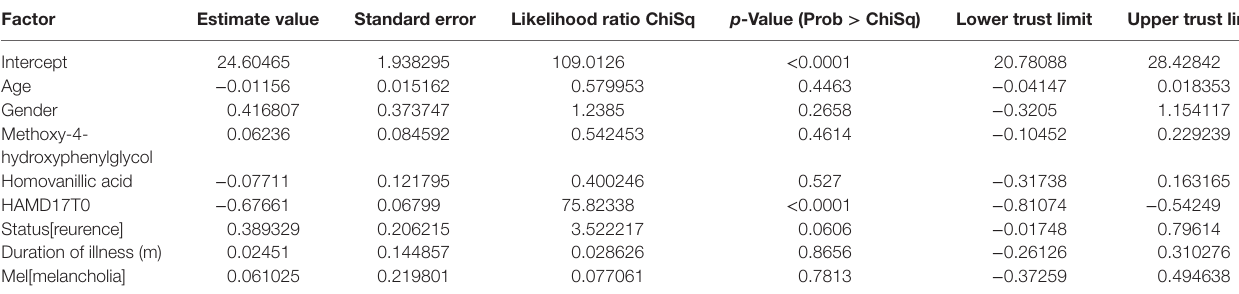
TaBle 3 | Estimated value for each parameter revTKusing GLM